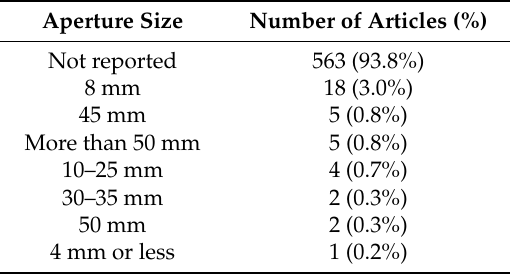
Table 5. Data for port size studied for measuring milk